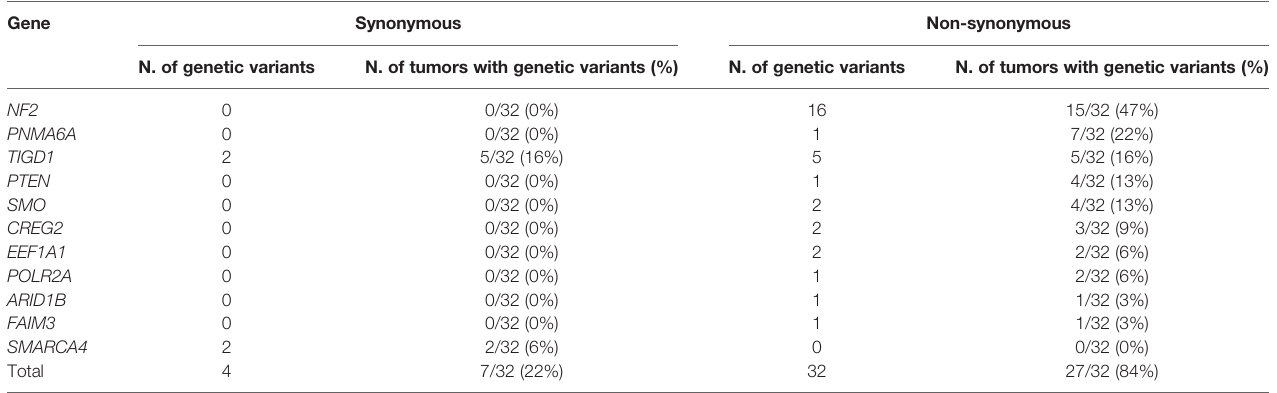
Gene Synonymous Non-synonymous N. of genetic variants N. of tumors with genetic variants